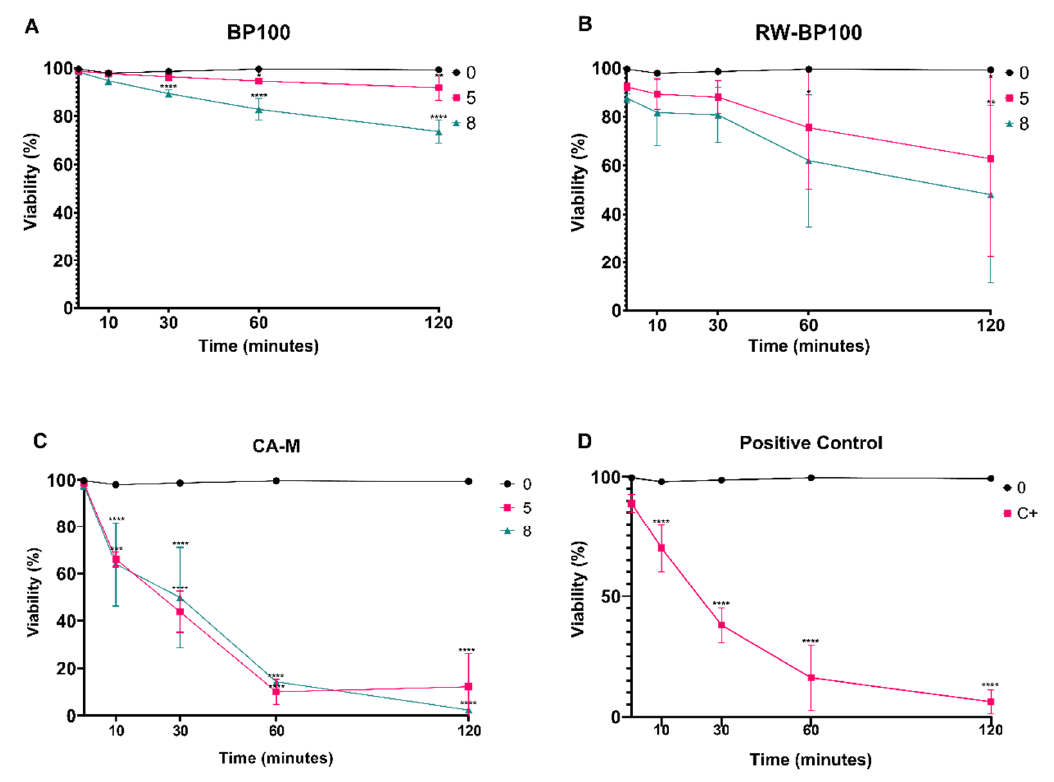
Figure 3. Viability of Erwinia amylovora strain LMG 2024 after exposure to increasing concentrations of AMPs during 120 min. ( A ) BP100; ( B ) RW-BP100; ( C ) CA-M; and ( D ) Isopropyl alcohol 23%. Viability was inversely proportional to propidium iodide (PI) fluorescence level in each time point. Vertical bars: mean value with standard deviation ( n = 3); *, **, ***, and **** refer to the statistical significances for differences in each time point of the analysis with p < 0.05, p < 0.01, p < 0.001, and p < 0.0001, respectively.